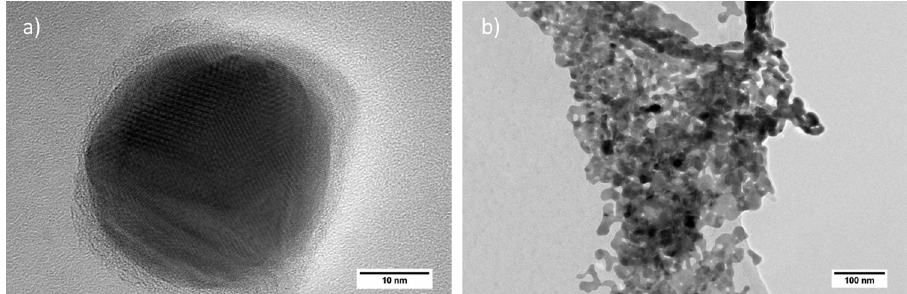
Figure 1: Selected TEM images for verifying Ag particle size via ( a ) high magni fi cation for particles stacked on top of each other and ( b ) overview picture using lower magni fi cation for particle size